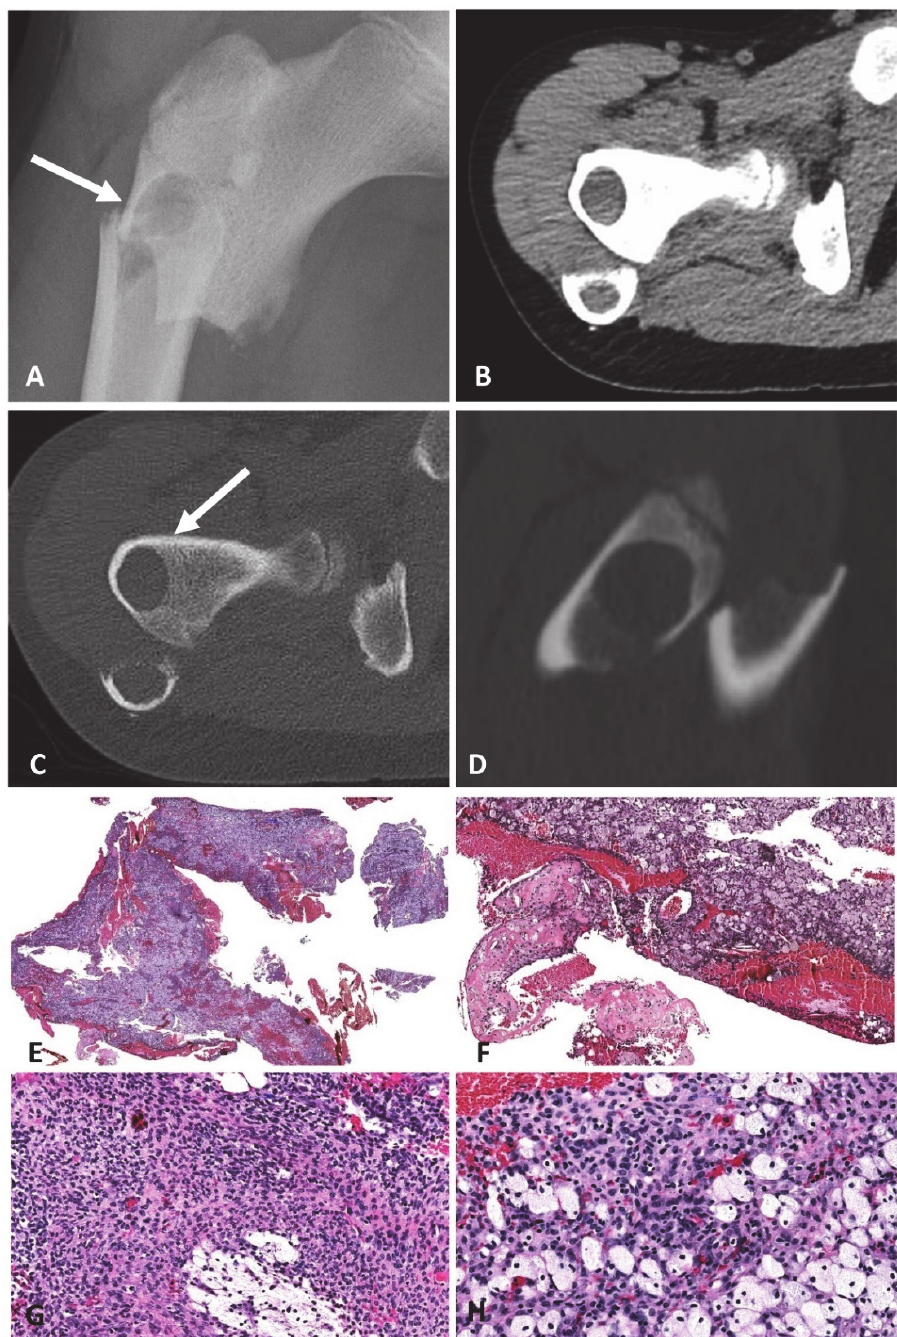
Figure 4. The 10-year-old-boy with a complex cystic tumor harboring a FUS::NFATC2 fusion in the right proximal femur (case #2). ( A ) The tumor is intramedullary, eccentric, well-defined, lytic, and associated with a displaced fracture. A small incidental enostosis is present in the femoral neck. ( B – D ) Soft-tissue ( B ) and high-resolution bone windows CT ( C , D ) show a well-defined lytic lesion with a thin sclerotic margin (arrow). The tumor contains hyperdense tissue, which probably represents blood ( B ). ( E – H ) Histology shows a cystic lesion composed of sheets of foamy histiocytes and bland spindled and ovoid cells that have vesicular nuclei, and pale eosinophilic cytoplasm. In one area, unmineralized fibrinous, cementum-like tissue ( F ) is